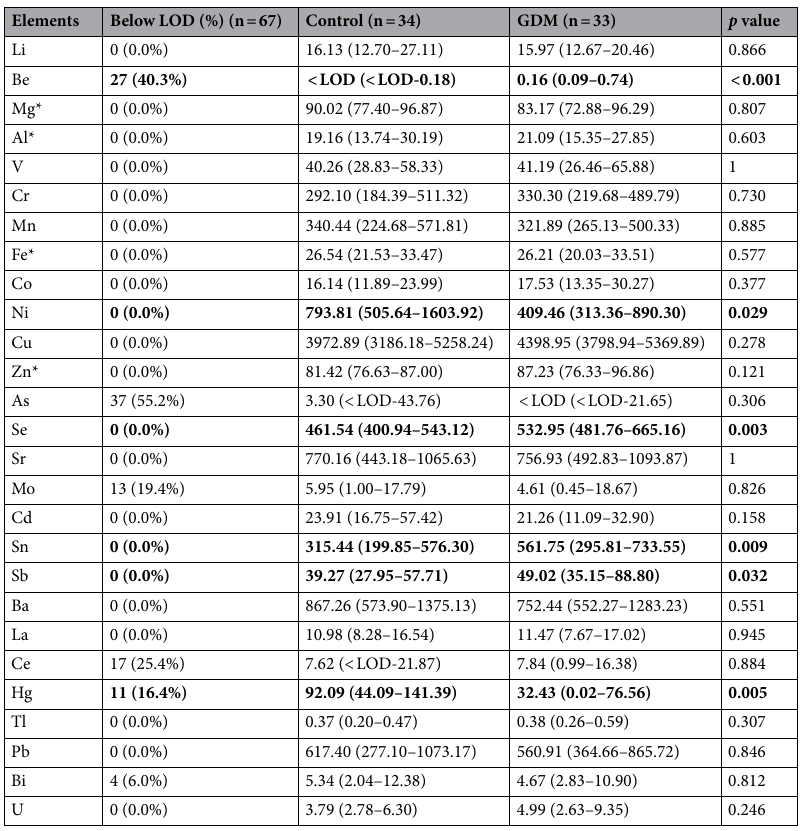
Table 2. Elemental concentrations in fingernails of control and GDM group. Concentration presented in median (IQR) (ng/g). *Concentration presented in median (IQR) (µg/g). Bolded: p value calculated by Mann– Whitney U test.